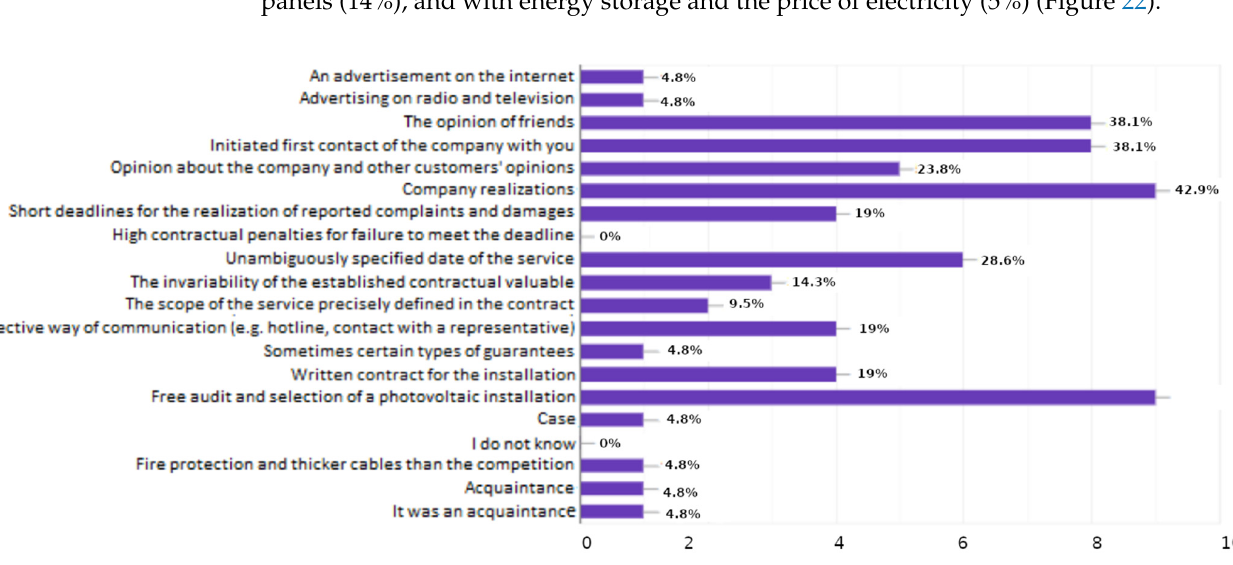
Figure 19. Contact with the service provider’s employees. The customer service process also includes warranty service. In the given responses, as many as 43% of respondents have a warranty period of more than 10 years, whereas in 24% there were warranty services after the installation of photovoltaic panels (Figure 20).